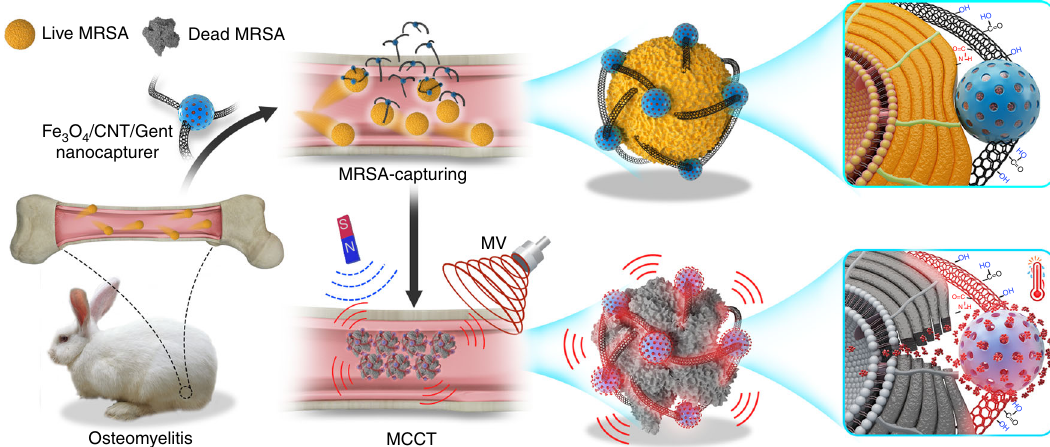
Fig. 1 The schematic illustration of the microwaveocaloric-chemotherapy (MCCT) of Fe 3 O 4 /CNT/Gent. The CNT displayed on the nanocapturer potently captured MRSA. When microwave-excited, the nanocapturers of Fe 3 O 4 /CNT are activated to generate thermal energy, which can locally melt PCM (the melting point is ~40 °C) and then locally release drug (Gent) at the site of the osteomyelitis with MRSA infection, fi nally eradicating MRSA precisely by combined the MCCT and an external magnetic fi